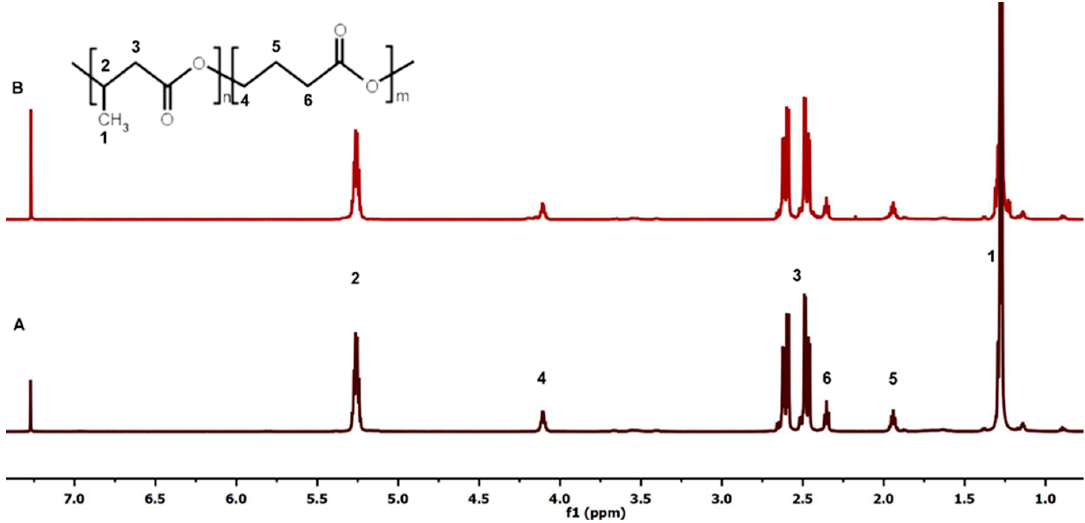
Figure 5. 1 H NMR spectrum of P(3HB- co -4HB) before ( A ) and after 21 days of degradation in distilled water ( B ).